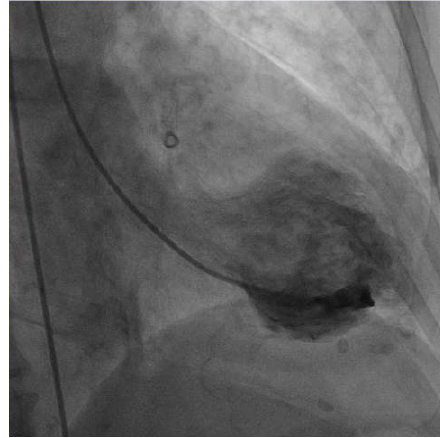
Figure 2. Left ventriculogram with a hypercontractile base and apical akinesis, typical in